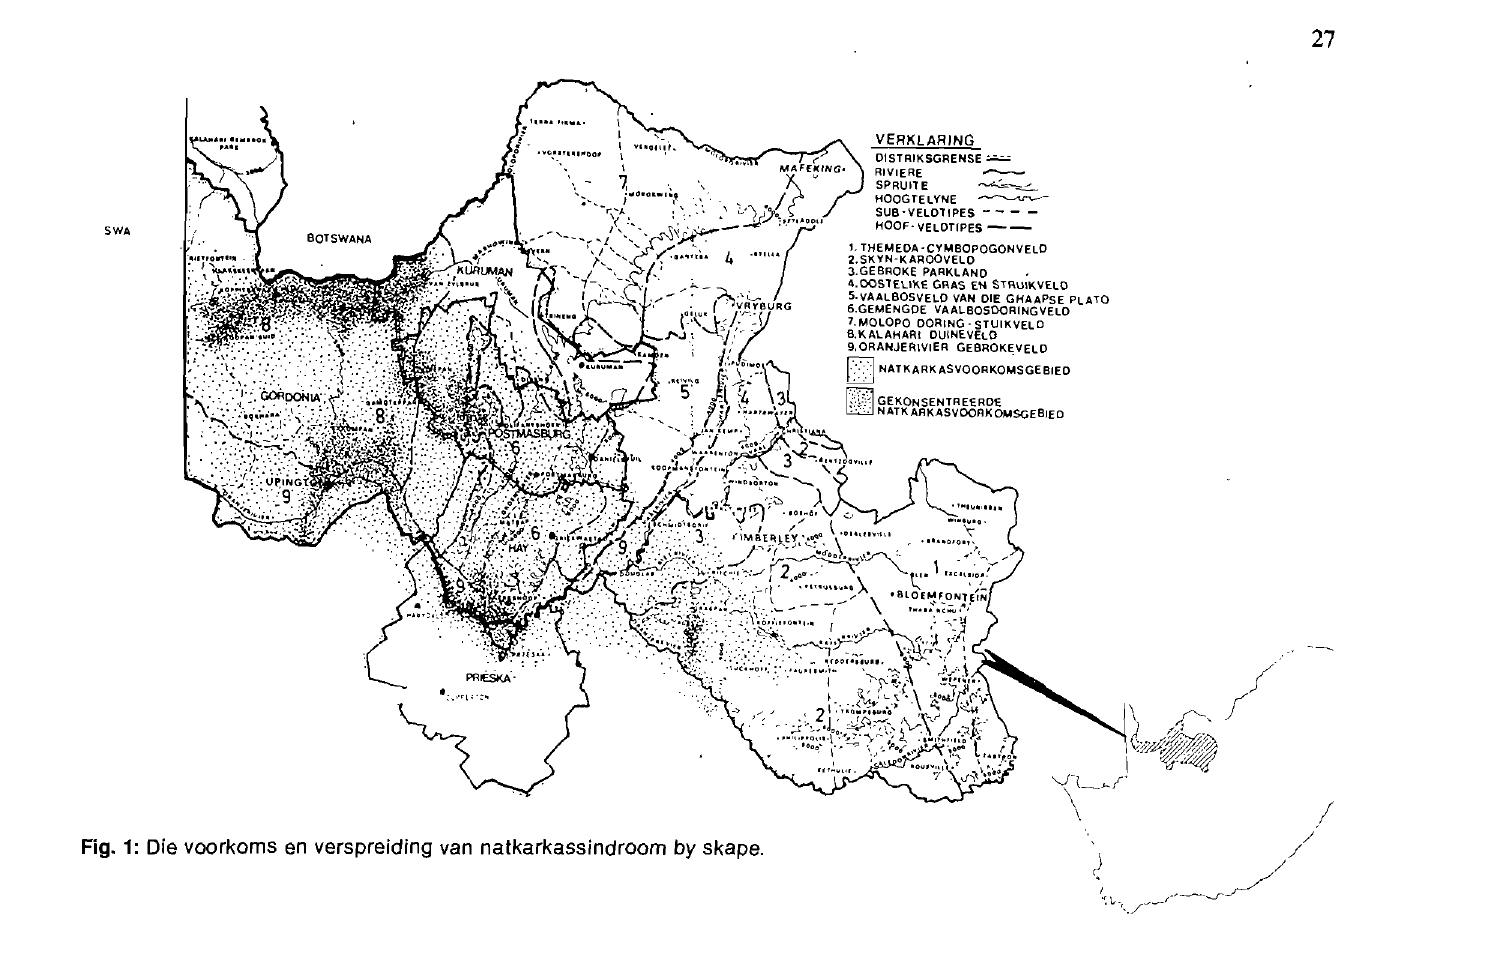
Fig. 1: Die voorkoms en verspreiding van natkarkassindroom by